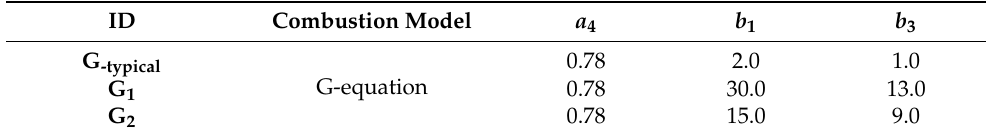
Table 7. Modeling constants study